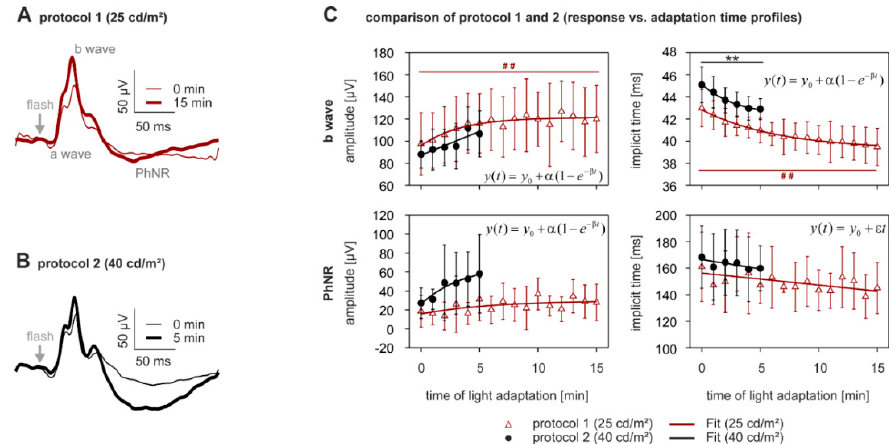
Figure 1. Light adaptation—a- and b-wave analysis of the photopic flash electroretinogram (ERG). ( A ) Subject averaged flash ERGs directly (0 min; thin curve) and 15 min (thick curve) after the onset of a 25 cd/m 2 adapting light; ( B ) As in (A) directly (0 min; thin curve) and 5 min (thick curve) after the onset of a 40 cd/m 2 adaptating light; ( C ) B-wave (upper plots) and photopic negative response (PhNR) (lower plots) amplitudes (left plots) and implicit times (right plots) as a function of adaptation time to photopic adaptation (red open triangles: 25 cd/m 2 ; black closed circles: 40 cd/m 2 ; means ± s.d.). The data are fitted by the functions described in the insets of the plots. n 25 cd/m2 = 10, n 40 cd/m2 = 9. The large variability in the PhNR amplitudes is caused by the interference of respiration movements on the ERG signal. Table 1. Summary statistics of changes in ERG components during light adaptation. All data shown in Figures 1C and 2C were tested with a Friedmann-test, which considers all measured time points, while the animal was light adapted. Significance levels were corrected via the Bonferroni method: α Bonferroni = 0.005. p -values that were below this significance level are highlighted.